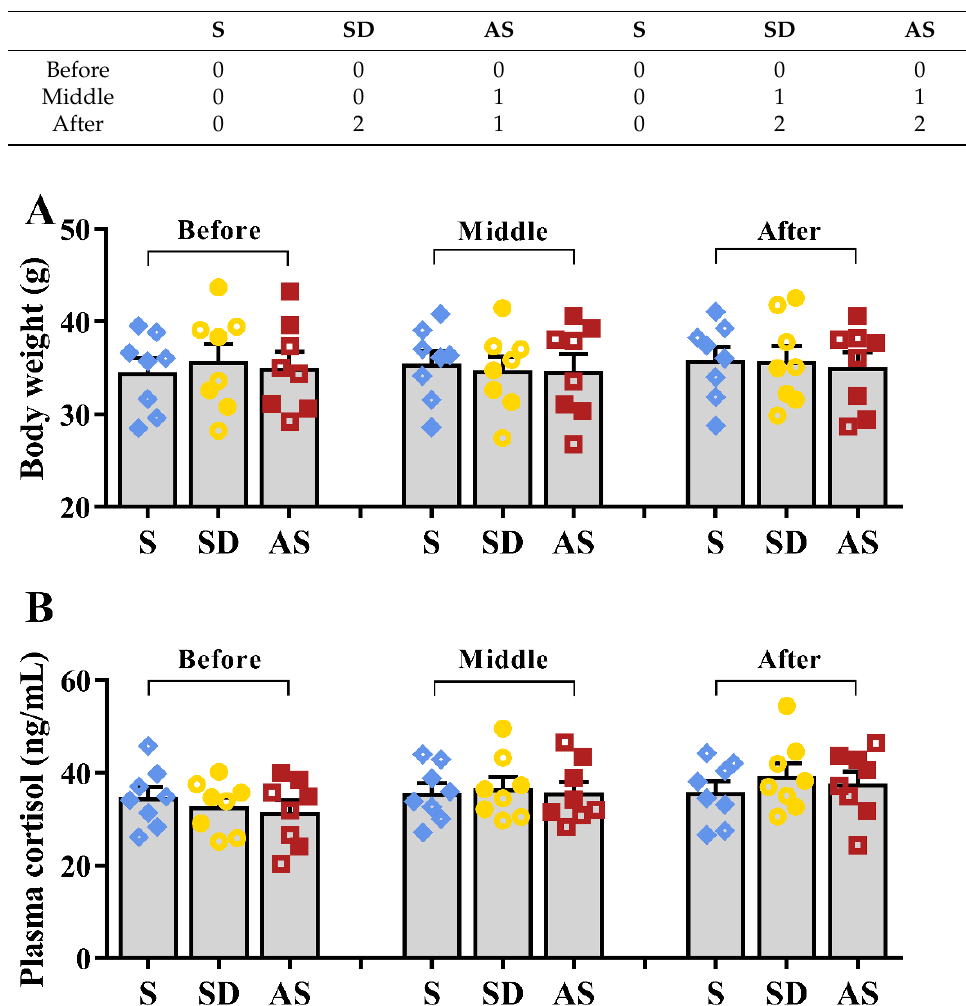
Figure 2. Chronic sleep deprivation did not cause stress responses. ( A ) Body weight during the sleep deprivation period. ( B ) Plasma cortisol levels during the sleep deprivation period. One-way ANOVA followed by two-sample LSD t tests is used. Data are expressed as mean ± SEM. Closed dots constitute male mice, and open dots constitute female mice.